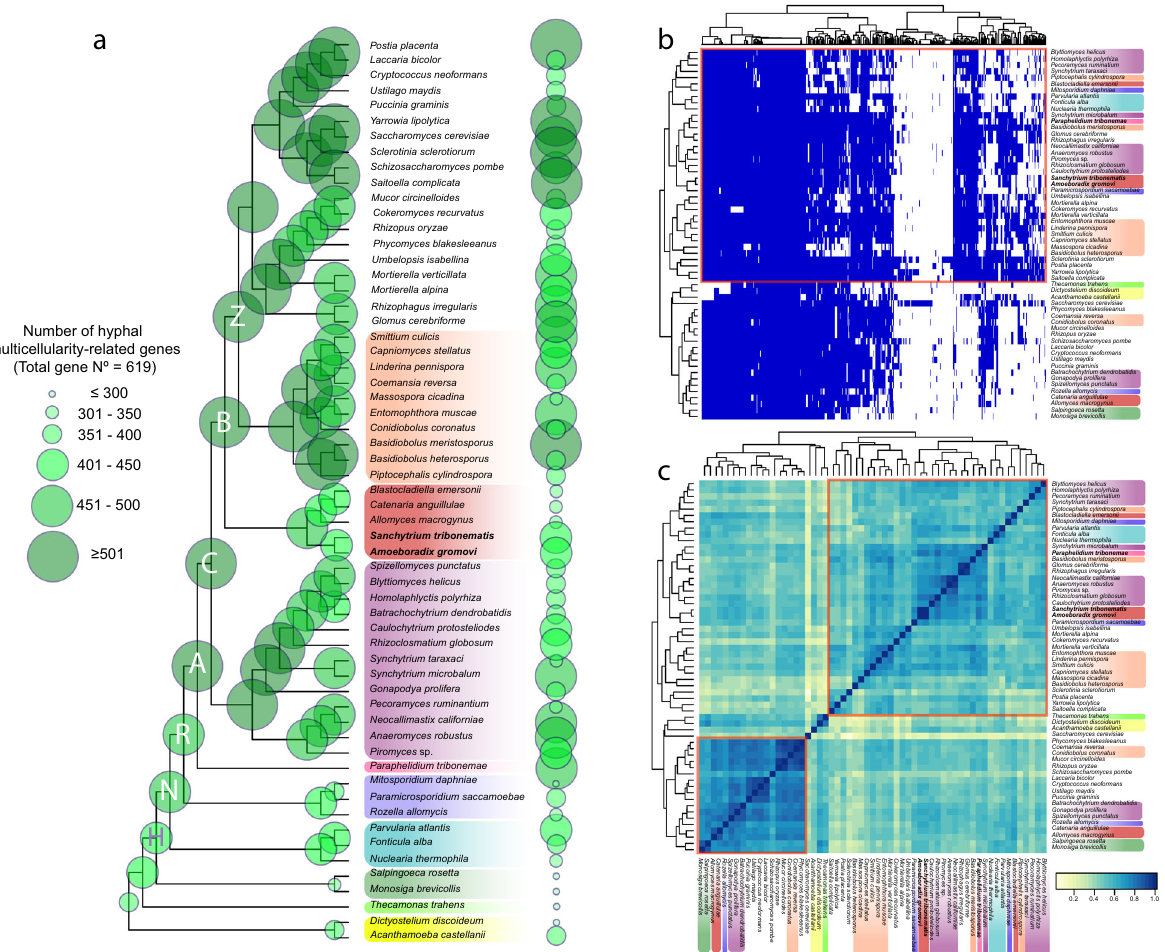
Fig. 5 Hyphae-related genes across Holomycota. a Cladogram of Holomycota depicting the phylogenetic relationships according to the GBE59 phylogenomic reconstruction. Bubble size on the nodes and tips represents the total number of reconstructed ancestral and extant hyphal multicellularity- related proteins. CBZ (Chytridiomycota, Blastocladiomycota and Zoopagomycota) and NRA (nucleariids, Rozellida – Microsporidia and Aphelida) nodes are indicated with letters within the corresponding bubbles. Unicellular lineages are highlighted in colours according to their taxonomic af fi liation (bottom to top: Amoebozoa [yellow], Apusomonadida [light green], Holozoa [dark green], nucleariids [light blue], Rozellida – Microsporidia [purple], Aphelida [pink], morphogenesis proteins in 59 unicellular (taxa are colour-highlighted as in a ) and multicellular (not colour-highlighted) eukaryotic proteomes. Gene presence is depicted in blue and absence in white. c Heatmap clustered by similarity showing the correlation between unicellular (taxa are colour- highlighted as in a ) and multicellular (not colour-highlighted) taxa according to the presence/absence of hyphal morphogenesis gene